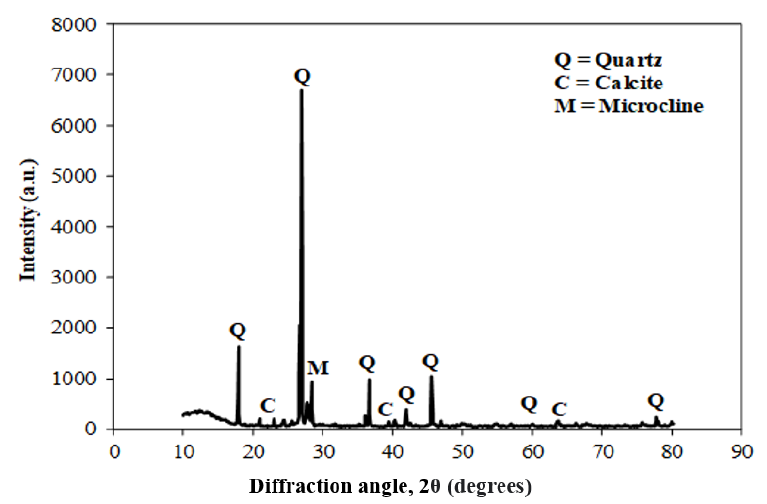
Figure 7. XRD of quarry dust.